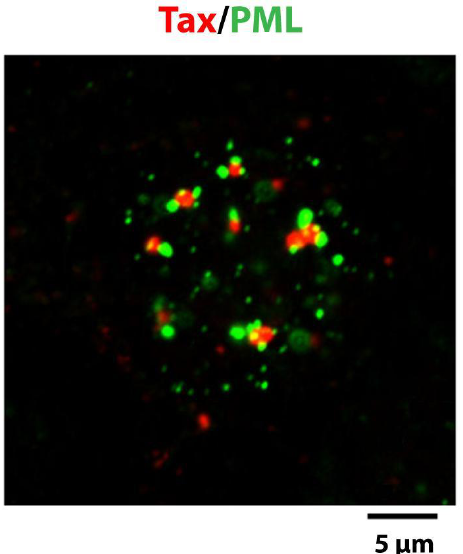
Figure 4. The Tax NBs and the PML NBs are distinct and adjacent entities. Immunofluorescent staining of the nucleus of a Hep2 cell expressing Tax with an anti-Tax monoclonal antibody (red) and an anti-PML rabbit polyclonal serum